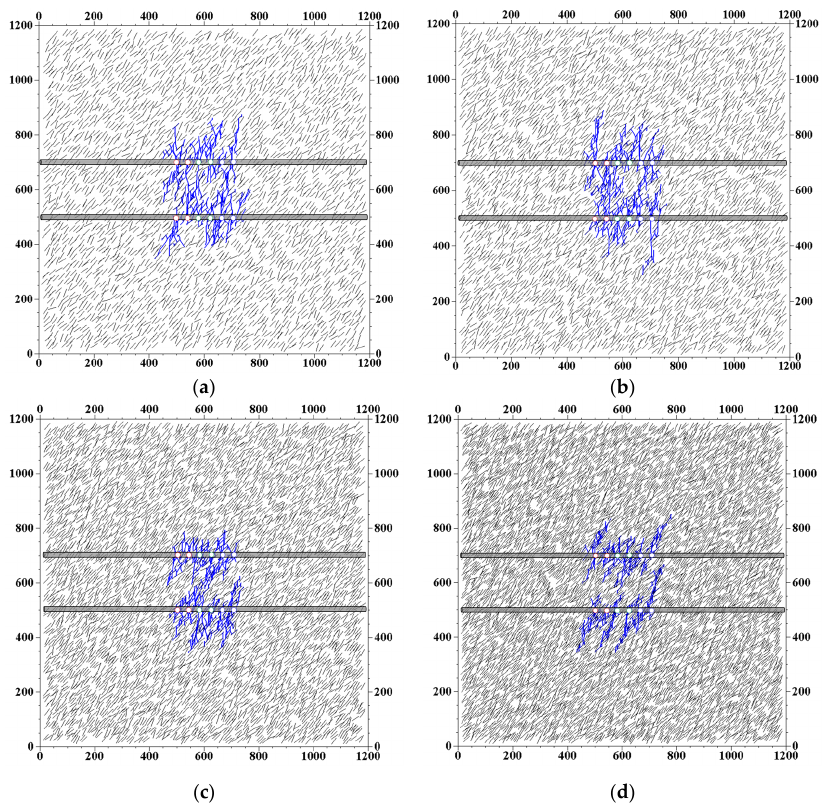
Figure 15. HF geometries for different NF densities: ( a ) 0.06 m/m 2 ; ( b ) 0.07 m/m 2 ; ( c ) 0.09 m/m 2 ; ( d ) 0.13 m/m 2 .